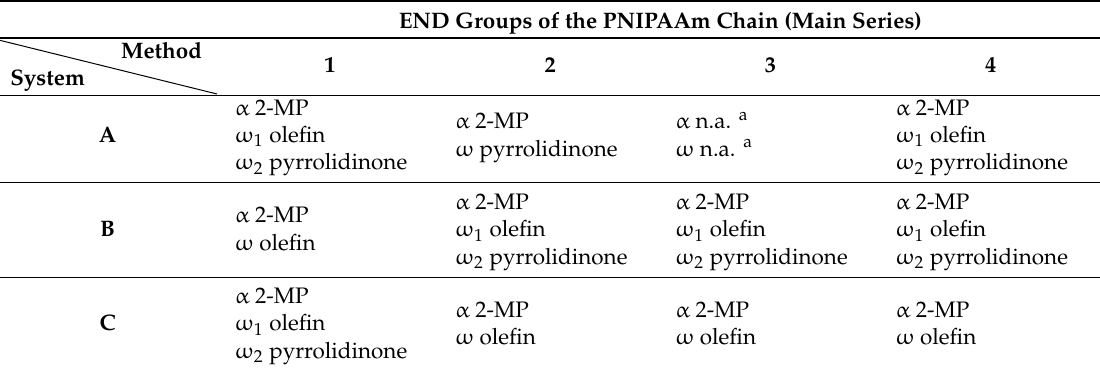
Table 4. Summary of the end group determination using ESI-TOF mass spectrometry. END Groups of the PNIPAAm Chain (Main Series) System